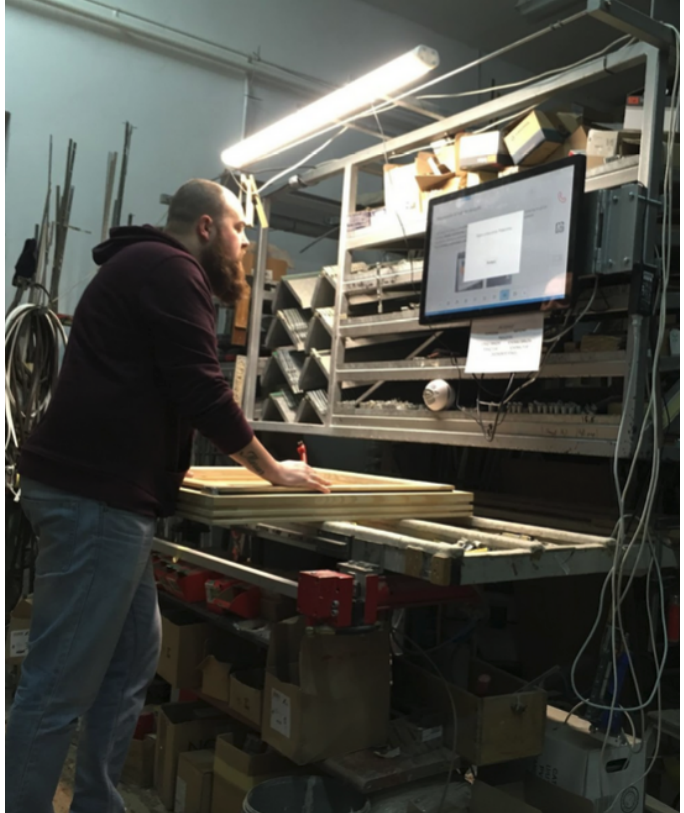
Figure 5. Interactive assisted assembly stand.